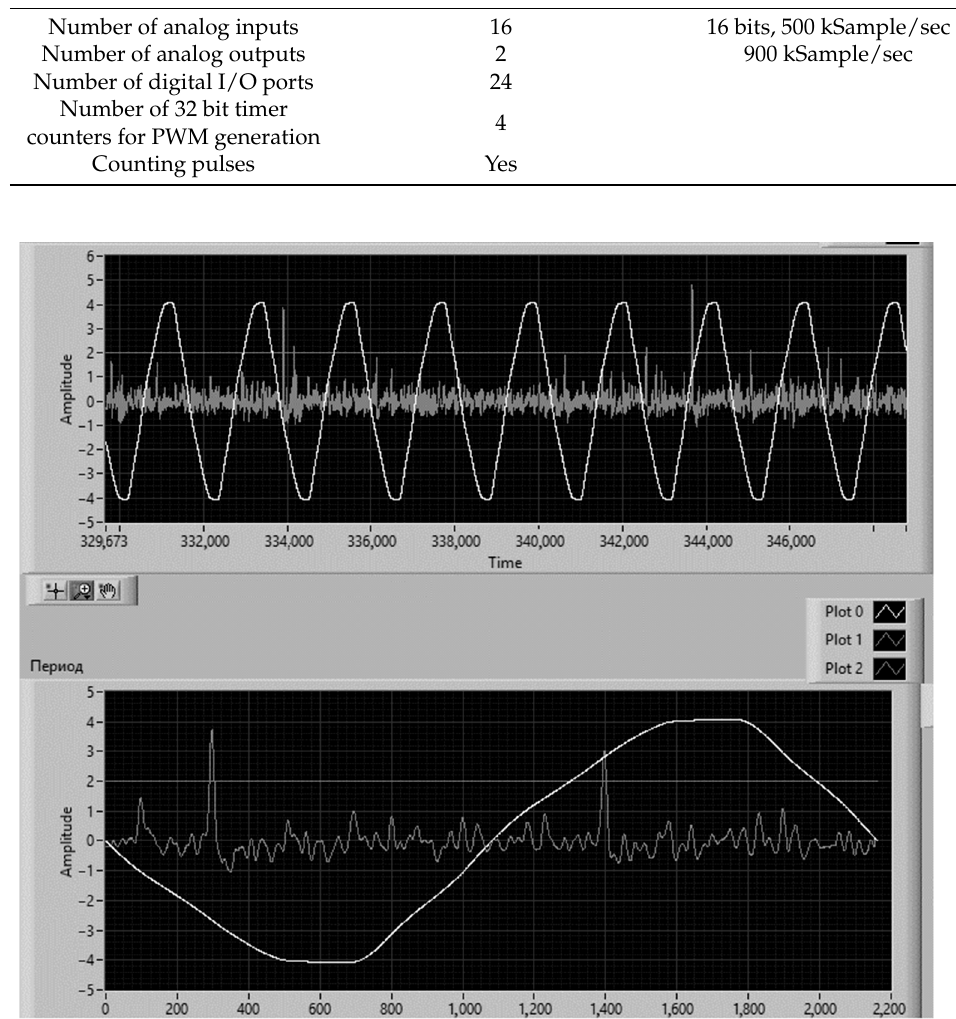
Figure 3. Representation of PD signal processing from an antenna at 545 MHz with a bandwidth of 15